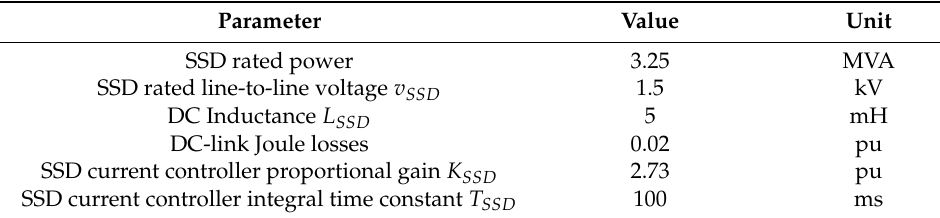
Table 3. SSD converter electrical and control system parameters.